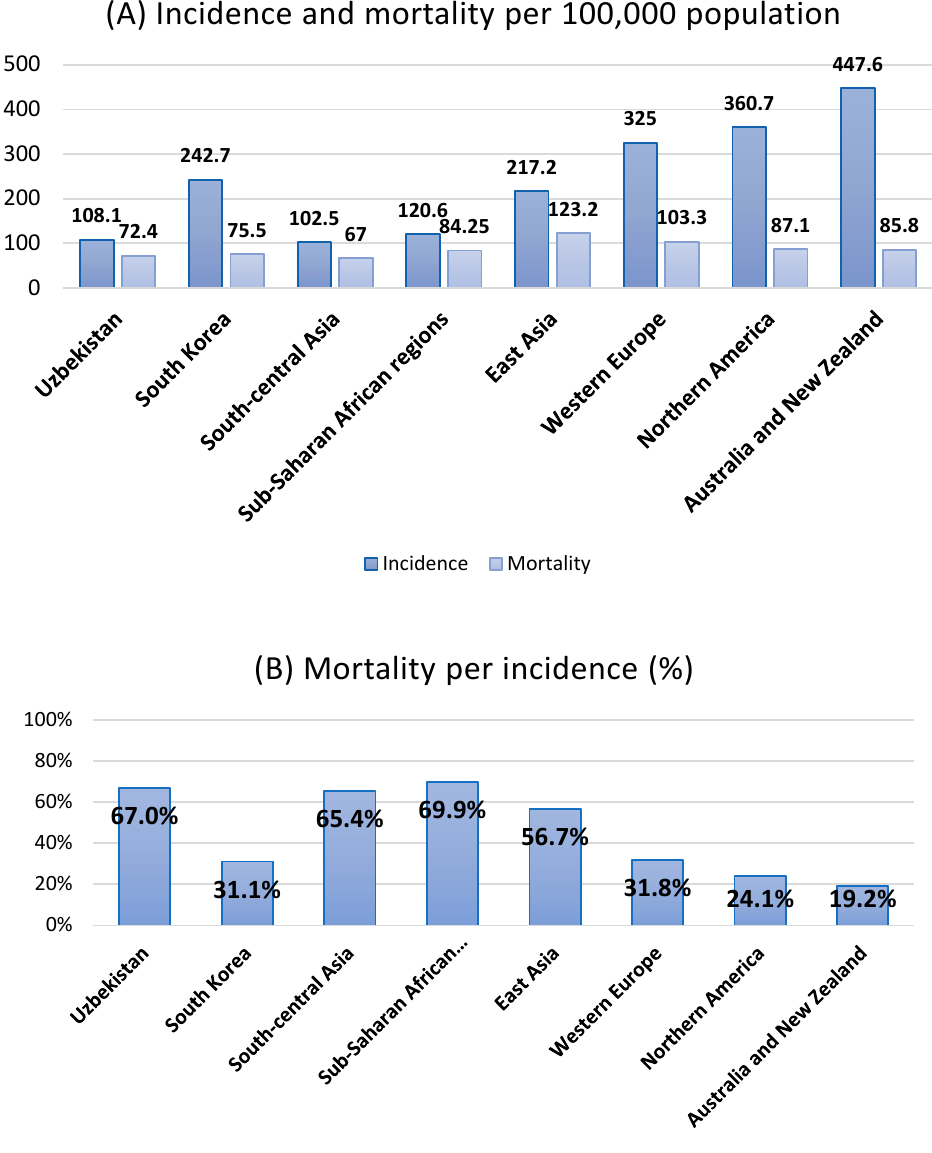
Figure 1. ( A ) The global incidence and mortality of all cancers per 100,000 population according to regions. ( B ) Mortality per incidence (age-standardized mortality per 100,000 people/corresponding incidence) percentile according to regions. Data source: Data on the incidence and mortality are obtained from the 2020 GLOBOCAN [4,5,10].